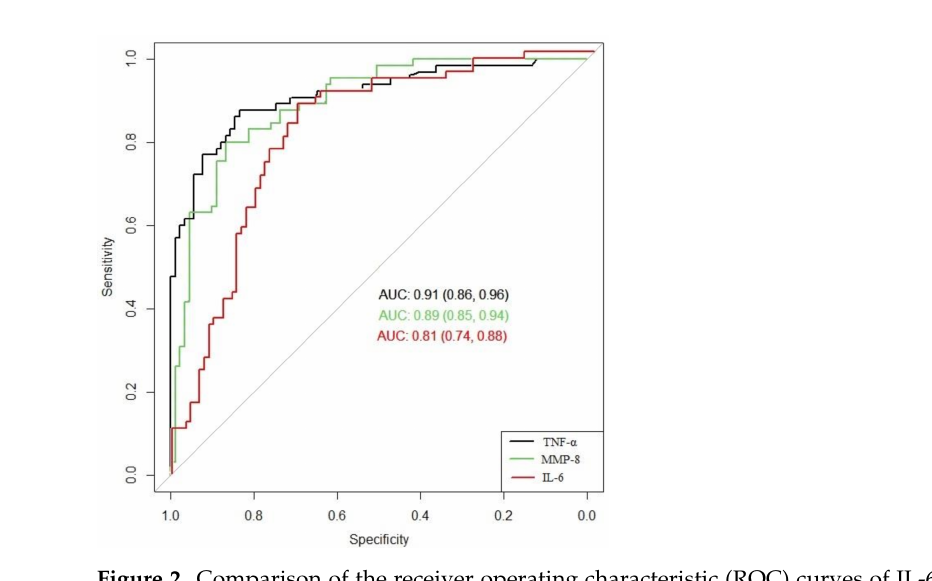
Figure 2. Comparison of the receiver operating characteristic (ROC) curves of IL-6, MMP-8, and TNF- α . AUC, area under the curve. Table 2. Cut-off levels for the sensitivity, specificity, and positive and negative predictive values of IL-6, TNF- α , and MMP-8. CI, confidence